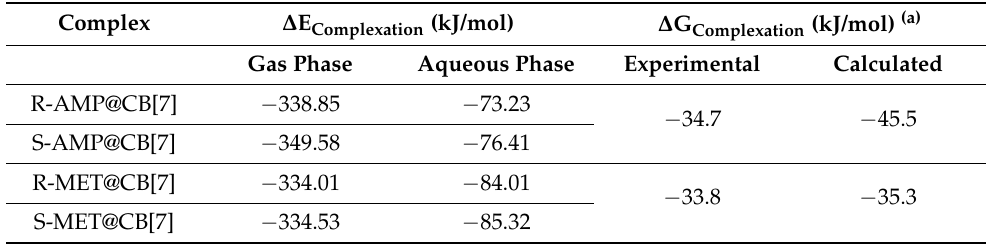
Table 2. Calculated complexation energies and standard Gibbs free energy (in kJ/mol) of CB[7] with AMP and MET at BLYP-D4/def2-TZVP-gCP level. Complex ∆ E Complexation (kJ/mol) Gas Phase Aqueous Phase